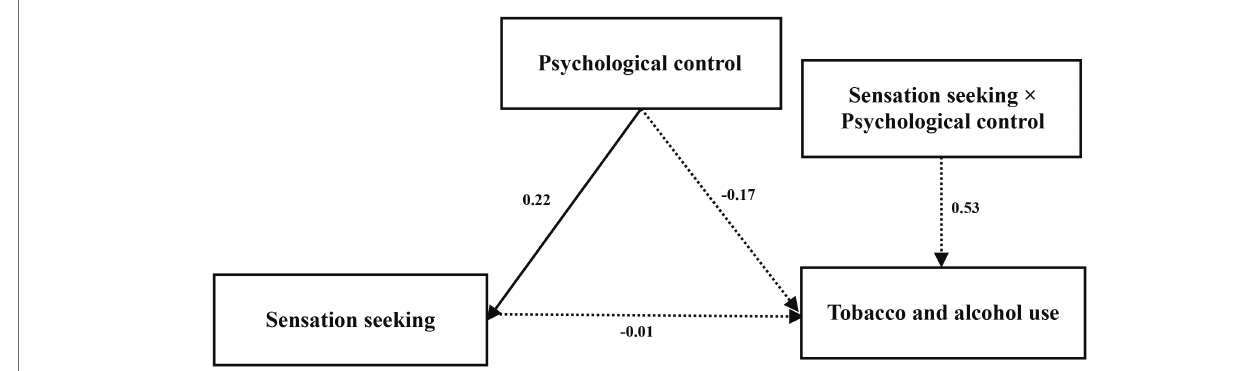
FIGURE 2 | Unconstrained model of urban area.